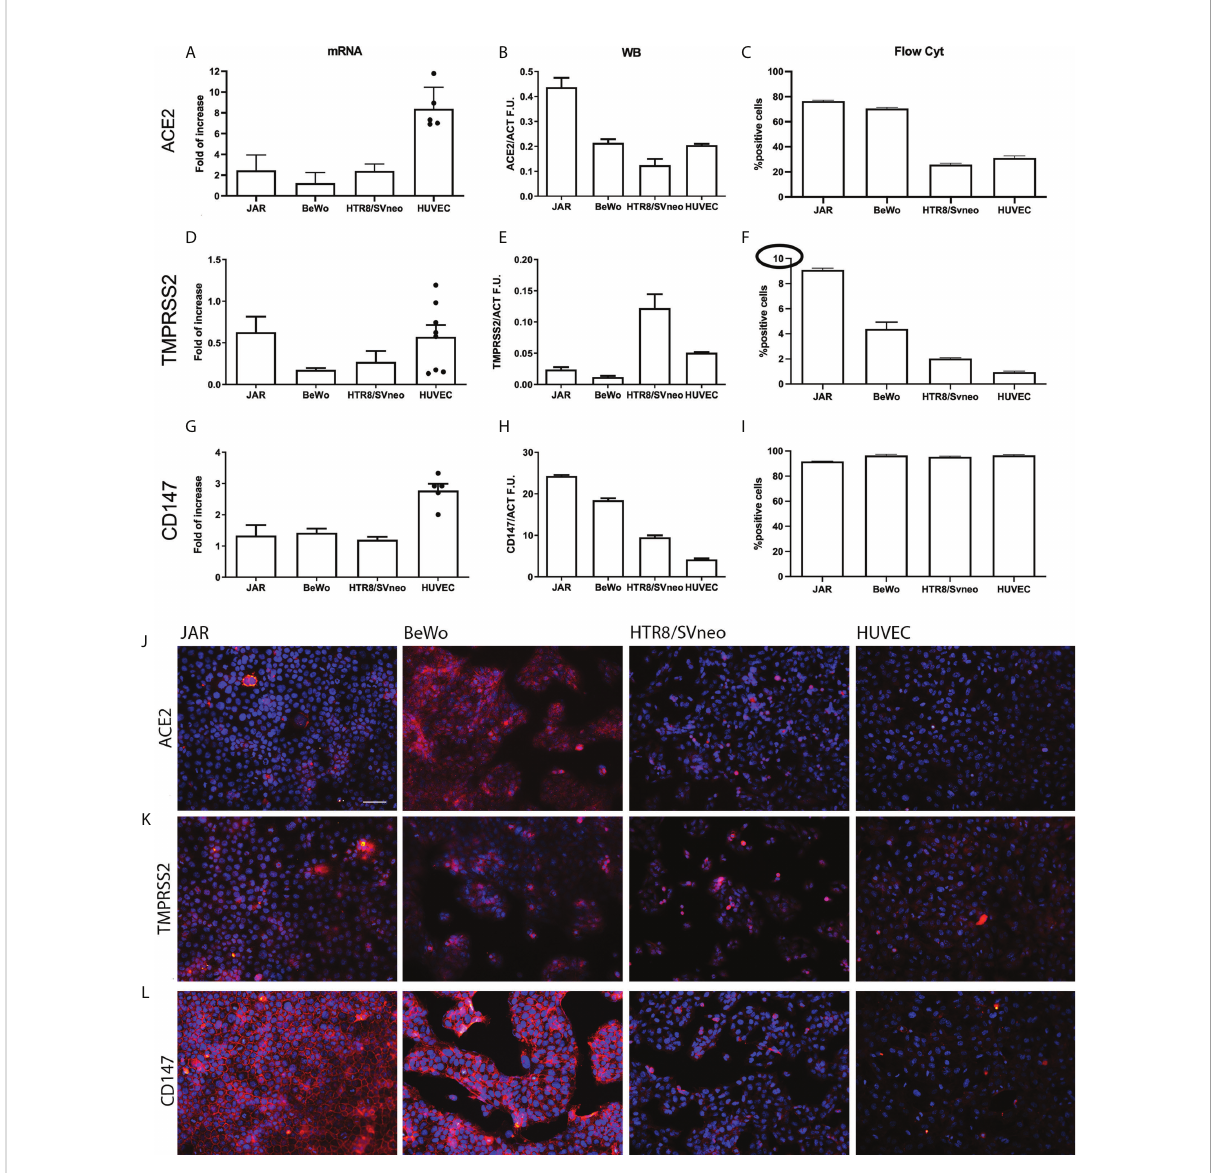
FIGURE 2 Characterization of SARS-CoV-2 entry receptors ’ expression in placental cell lines. Gene and protein expression levels of ACE2 (A-C) , TMPRSS2 (D-F) and CD147 (G-I) were evaluated by RT-qPCR, Western blot and fl ow cytometry in JAR, BeWo, HTR8/SVneo and HUVECs (n = 6, different populations are represented by dots). All the placental cell lines showed a low level protein expression of TMPRSS2 (highlighted by the circle in the different set up of the axis) and a high protein expression level of CD147, whilst ACE2 expression appeared more variable among them. (J-L) Immuno fl uorescence analysis of SARS-CoV-2 entry receptors in placental cell lines. JAR, BeWo, HTR8/SVneo and HUVECs were stained with anti-human ACE2 (J) , TMPRSS2 (K) or CD147 (L) primary antibodies, followed by Cy3-conjugated secondary antibodies (red). Nuclei were stained in blue with DAPI. Images were acquired with a Leica DM 3000 fl uorescence microscope using a Leica DFC 7000 camera. Scale bar, 50 m